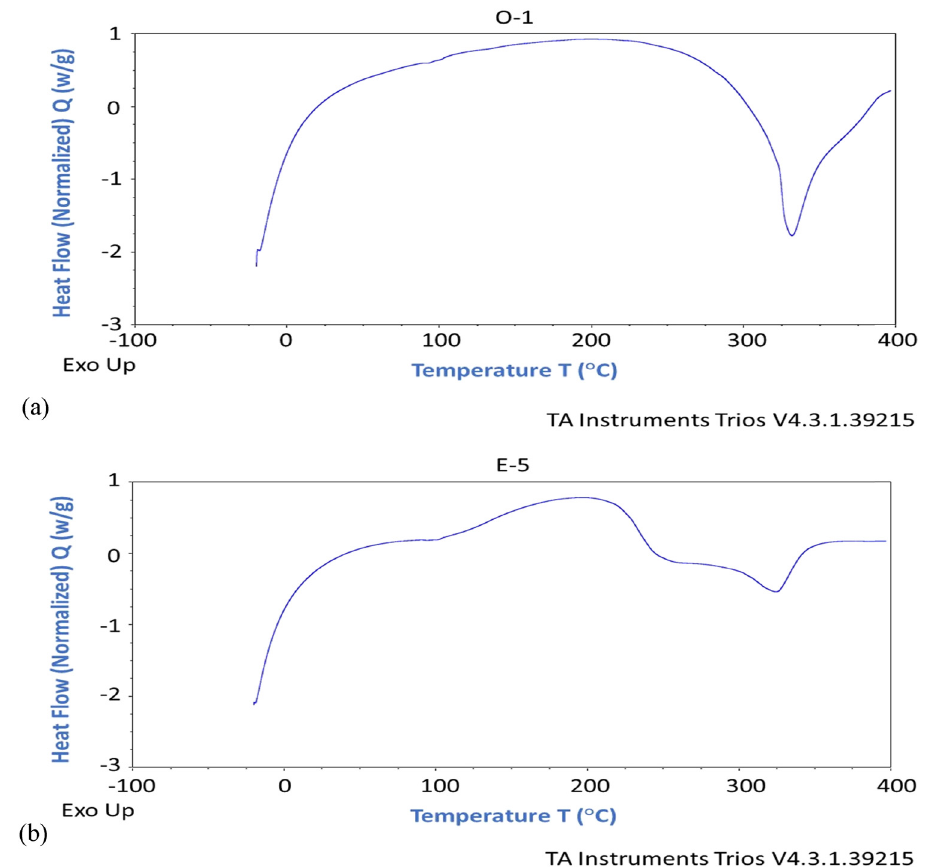
Figure 46: ( a ) DSC thermograms for neat recycled EVA polymer without any leather fi bers. ( b ) DSC thermograms for leather bu ffi ng dust/ recycled EVA polymer